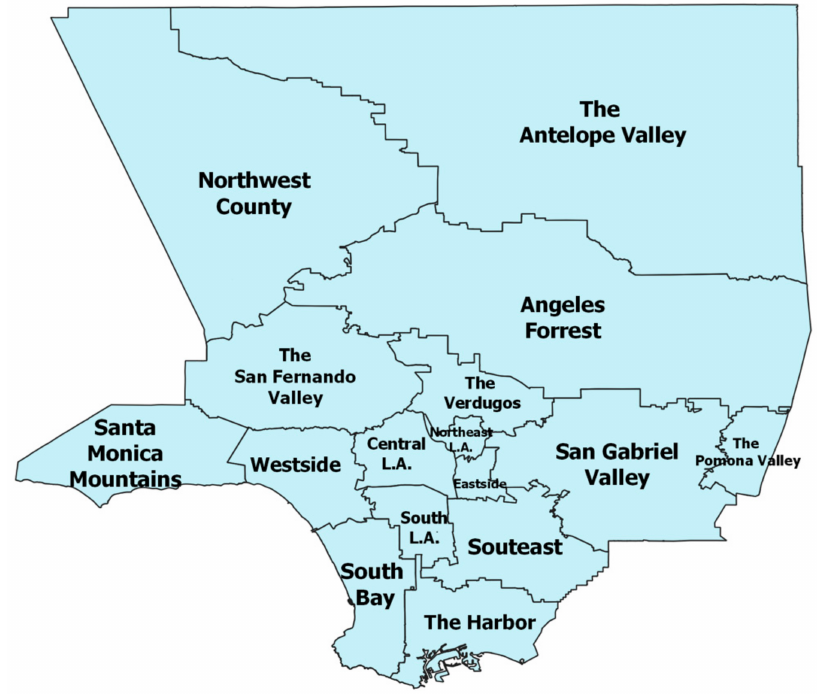
Figure 1. Los Angeles County Regions.